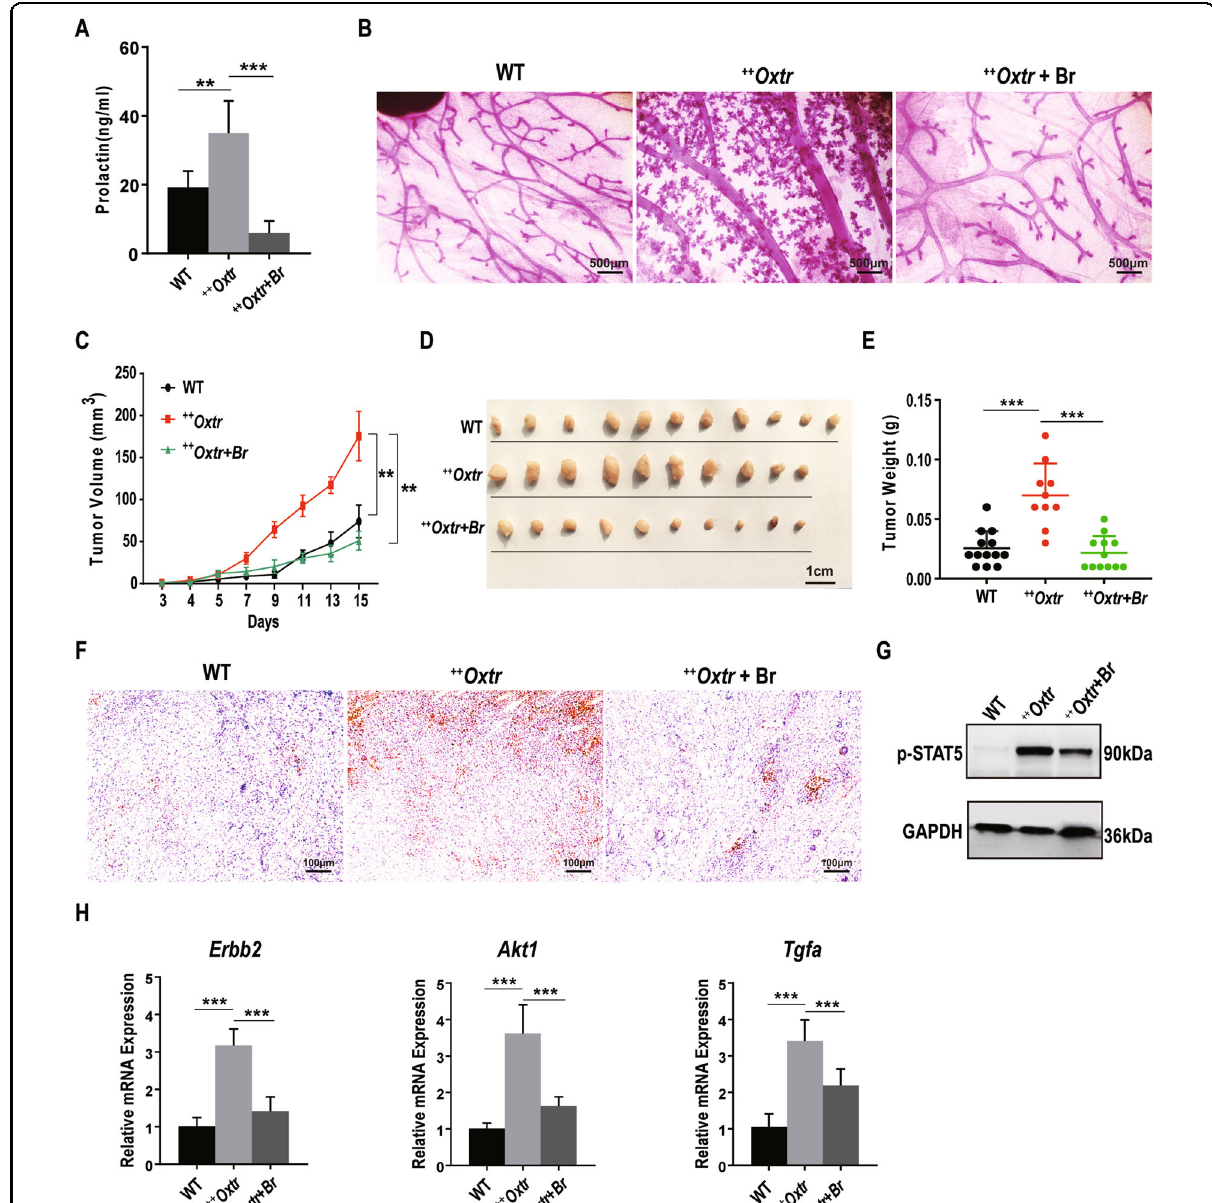
Fig. 5 Bromocriptine treatment of ++ Oxtr females results in compromised mammary gland development and tumor growth. After E0771 cells transplantation, ++ Oxtr females were treated with a vehicle or 200 ug (1 mg/ml) bromocriptine (Br) for 15 days. A Serum prolactin (PRL) levels of WT, ++ Oxtr , and ++ Oxtr females with Br treatment, n = 8. B Whole-mount staining of fourth mammary glands, Scale bar: 500 μ m. C Tumor growth ( n = 10) by tumor volume. D Representative photos of tumors. E Tumor weights, WT ( n = 13), ++ Oxtr ( n = 10), and ++ Oxtr with Br treatment ( n = 12). F p-STAT5 immunostaining of tumors. Nuclei were stained blue with hematoxylin. Scale bar: 100 μ m. G Immunoblotting analysis of p-STAT5 of tumors. H Gene expression of Erbb2 , Akt1 , and Tgf α in tumors by qPCR, n = 6. Data were represented as mean ± SD. ** P < 0.01, *** P < 0.001, calculated with one-way analysis of variance